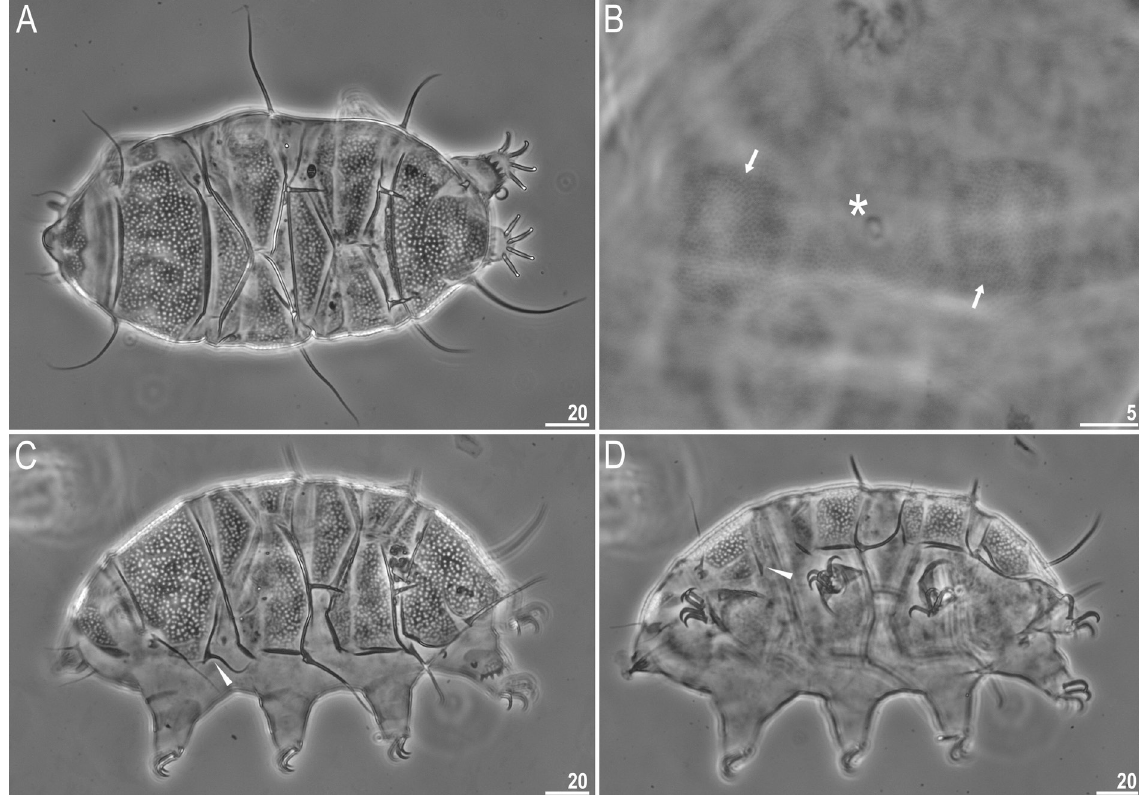
Fig. 5. Echiniscus quadrispinosus Richters, 1902, ♂. A* . Dorsal view of the entire animal with appendages B absent on both sides (chaetotaxy: A-C-C d -D-D d -E ). B* . Two ventral rounded plates on the lateral sides of the gonopore (arrows); asterisk indicates gonopore. C–D . Lateral view of male with appendage B present only on one side of the body (chaetotaxy: A-B-C-C d -D-D d -E ); arrowhead indicates presence and lack of appendage B . * = manually assembled deep-focus image. All PCM. Scale bars in micrometres